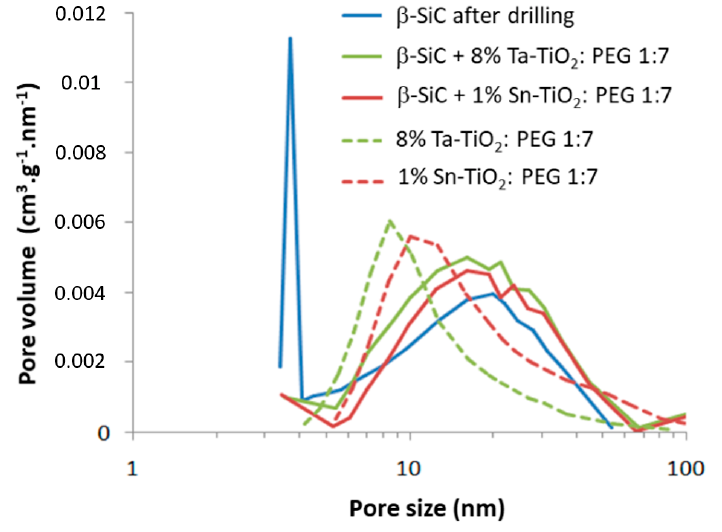
Figure 2. Porous distribution of β -SiC foams with or without catalyst compared to powdery material. The scale of [8% Ta-TiO 2 : PEG 1:7] and [1% Sn-TiO 2 : PEG 1:7] has been adjusted to be similar to the other curves.